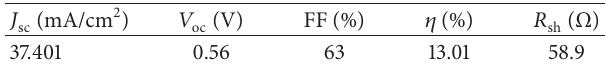
Table 5: Photoelectric properties of the fabricated solar cells subjected to a diffusion time of 120